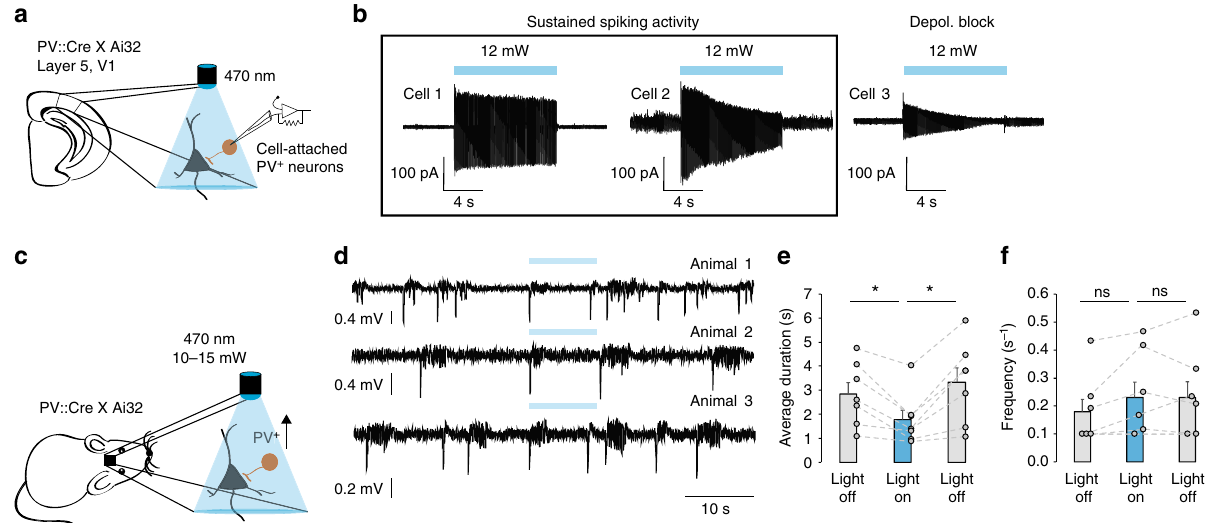
Fig. 2 Photo-depolarization of ChR2-expressing PV + interneurons reduces the duration of seizures. a Schematic of in vitro experiments and sample traces of cell-attached recordings from V1 layer 5 PV + interneurons in acute brain slices. b Cell-attached recordings showed that most PV + neurons are able to sustain fi ring during the 10 s-long light pulse (cells 1 and 2). Some cells (cell 3) show reduced fi ring towards the end of the light pulse. c In vivo experimental schematic. d ECoG traces showing epileptiform activity before, during and after several rounds of photostimulation of ChR2-expressing PV + interneurons. Ictal discharges have reduced duration during optogenetic stimulation, but rapidly recover as soon as the light is switched off. e Average duration of individual ictal discharges during the 10 s periods before, during and after light stimulation ( n = 7 mice, * p < 0.05, error bars represent s.e.m., one-way repeated measures ANOVA post hoc Bonferroni test). f Average number of ictal events during the 10 s periods before, during and after light stimulation ( n = 7 mice, error bars represent s.e.m., one-way repeated measures ANOVA post hoc Bonferroni test). Source data are provided as a Source Data fi